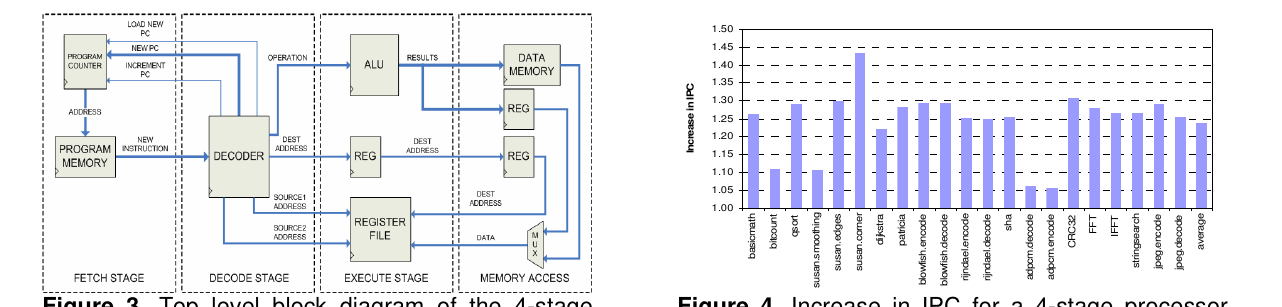
Figure 3. Top level block diagram of the 4-stage base processor.